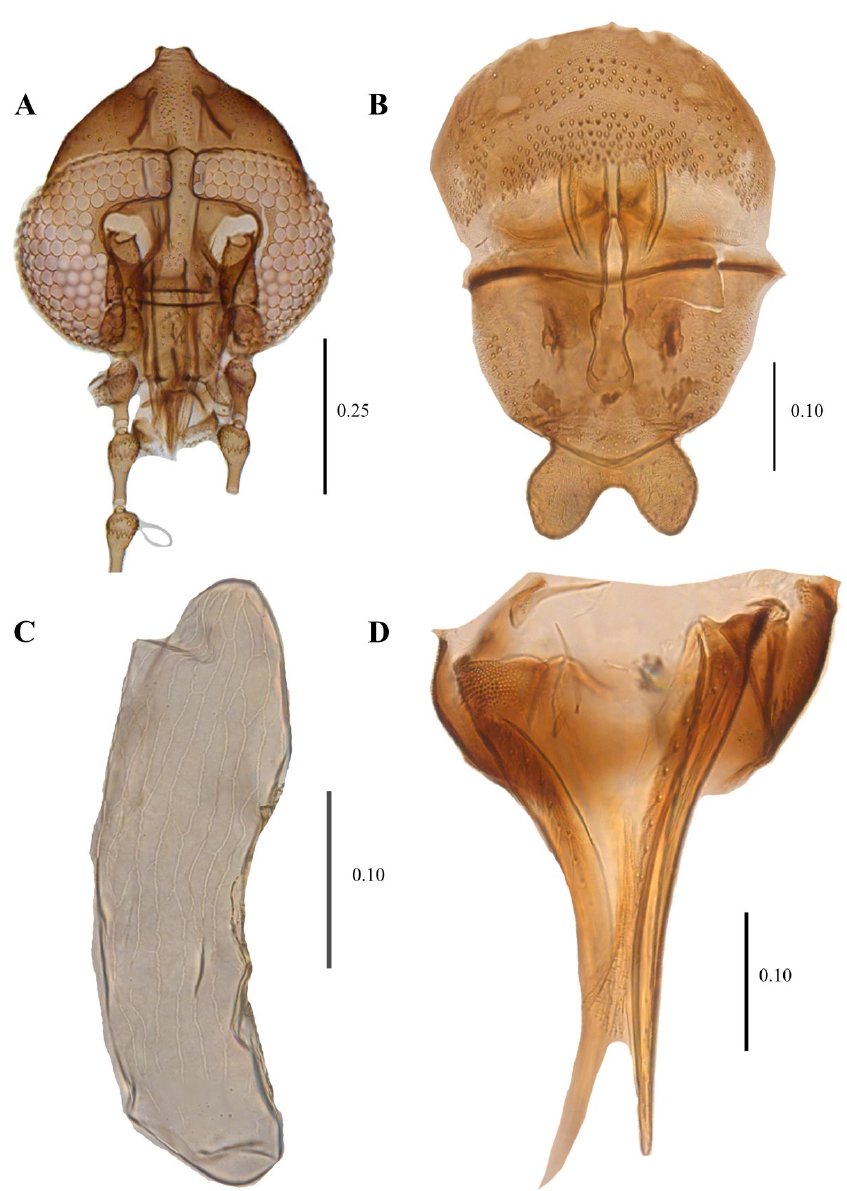
Figure 15. Telmatoscopus advena (Eaton, 1983), female. ( A ) Head. ( B ) Genital chamber. ( C ) Egg. ( D ) Cerci. Scale ( A – D ) in millimeters (mm).